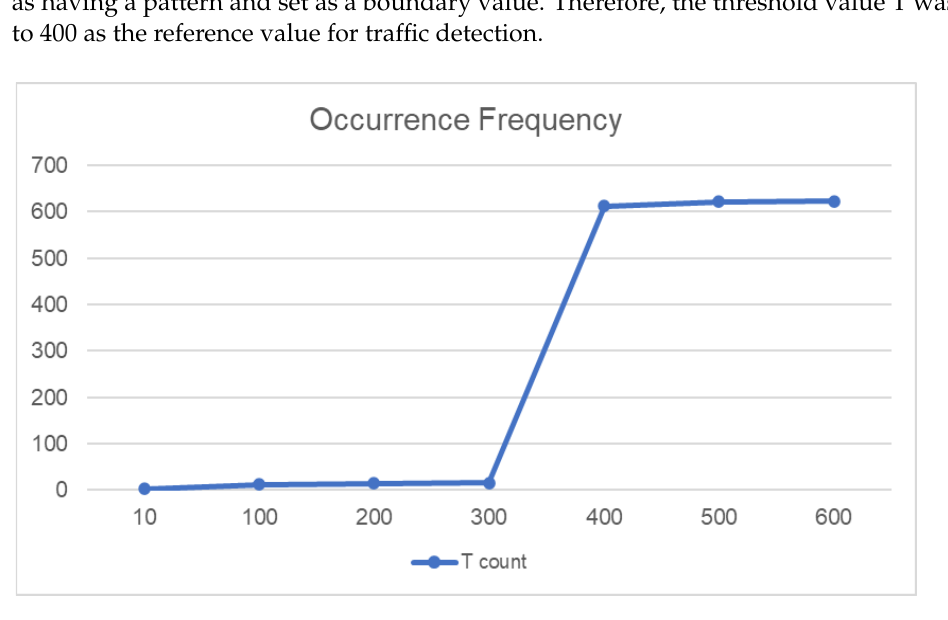
Figure 11. Packet size count of the proposed model .